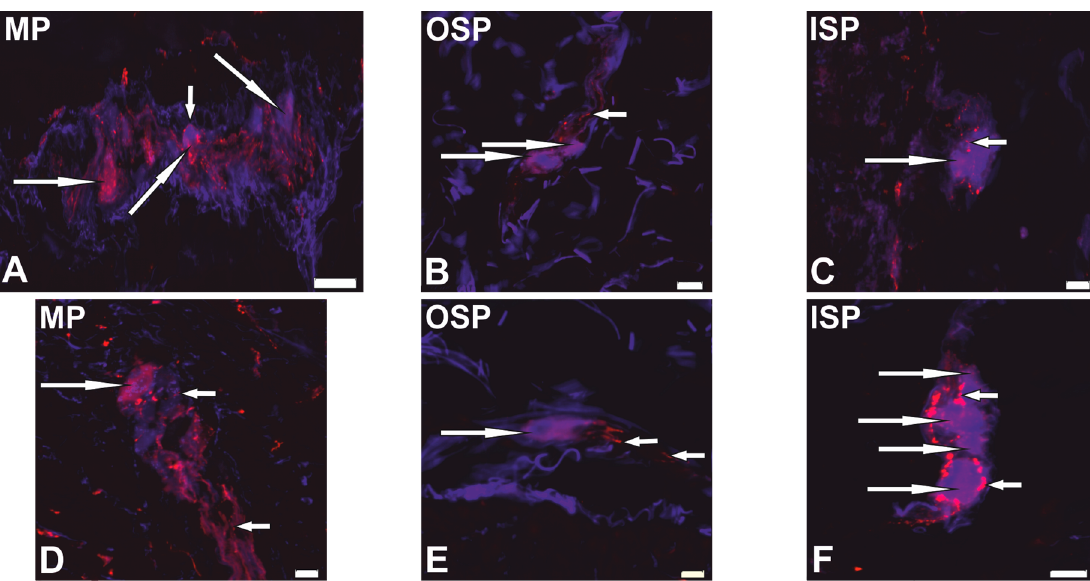
Figure 1. Distribution pattern of neurons (long arrows) and nerve fibers (short arrows) immunoreactive to protein gene-product 9.5 (PGP 9.5, blue) and cocaine- and amphetamine-regulated transcript (CART, red) within the myenteric plexus (MP), outer submucous plexus (OSP), and inner submucous (ISP) plexus of the control ( A – C ) and cancer-affected ( D – F ) human colonic wall. Figures ( A – F ) show the overlap of both stainings. Scale bar = 20 µm.